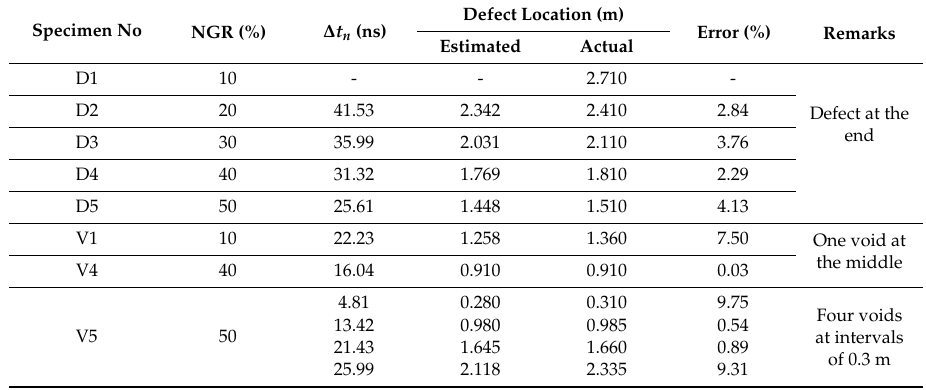
Table 2. Round-trip travel times reflected at defects ( ∆ t n ) and estimated defect locations for defective rock bolts in non-embedded